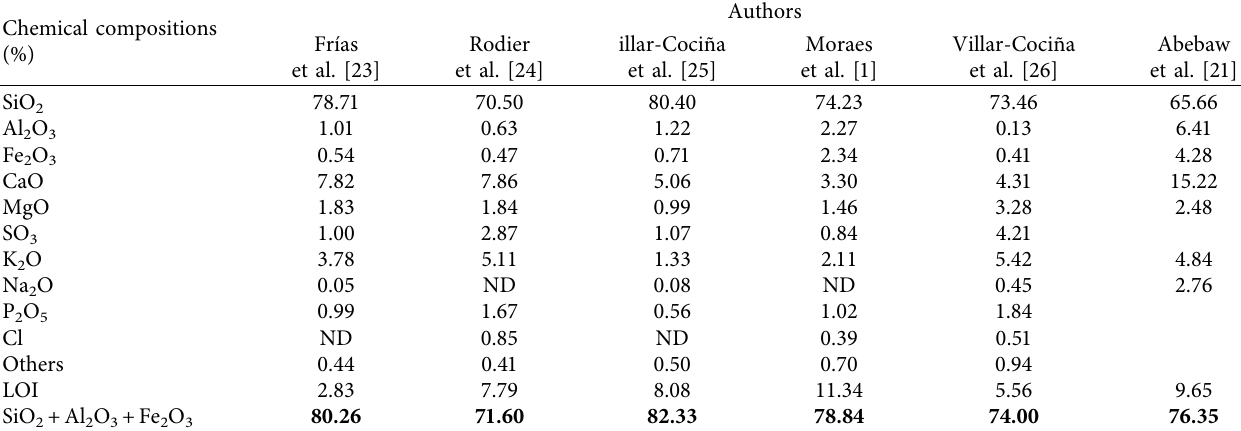
Table 1: Chemical compositions of bamboo leaves’ ashes (BLA).